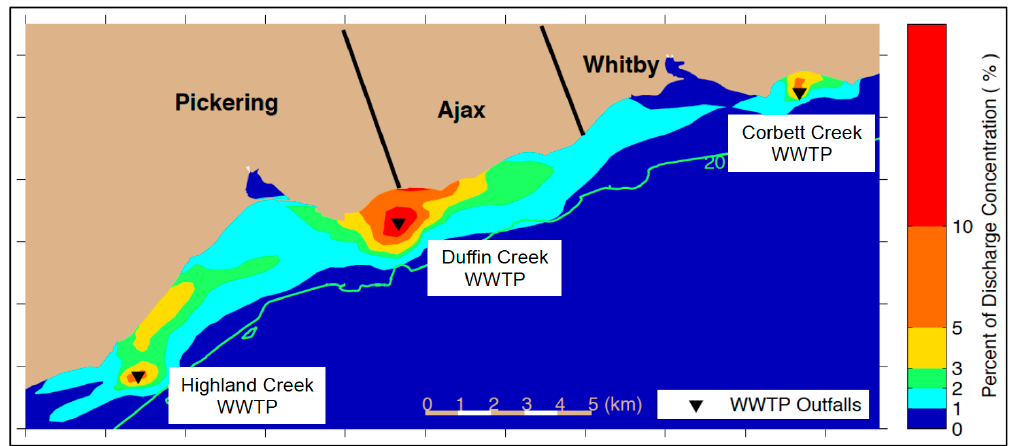
Figure 11. Conservative tracer concentration for a seven-day interval (13–19 July 2014), averaged over the water column and over the simulation period and expressed as a percentage of the discharge concentration. Results illustrate the domain of the plumes and their confluence to the west and separation to the east. The green line is the 20-m depth representing the approximate lakeward extent of colonization by Cladophora and taken as the separation of nearshore and offshore waters. Model results are from run#6.